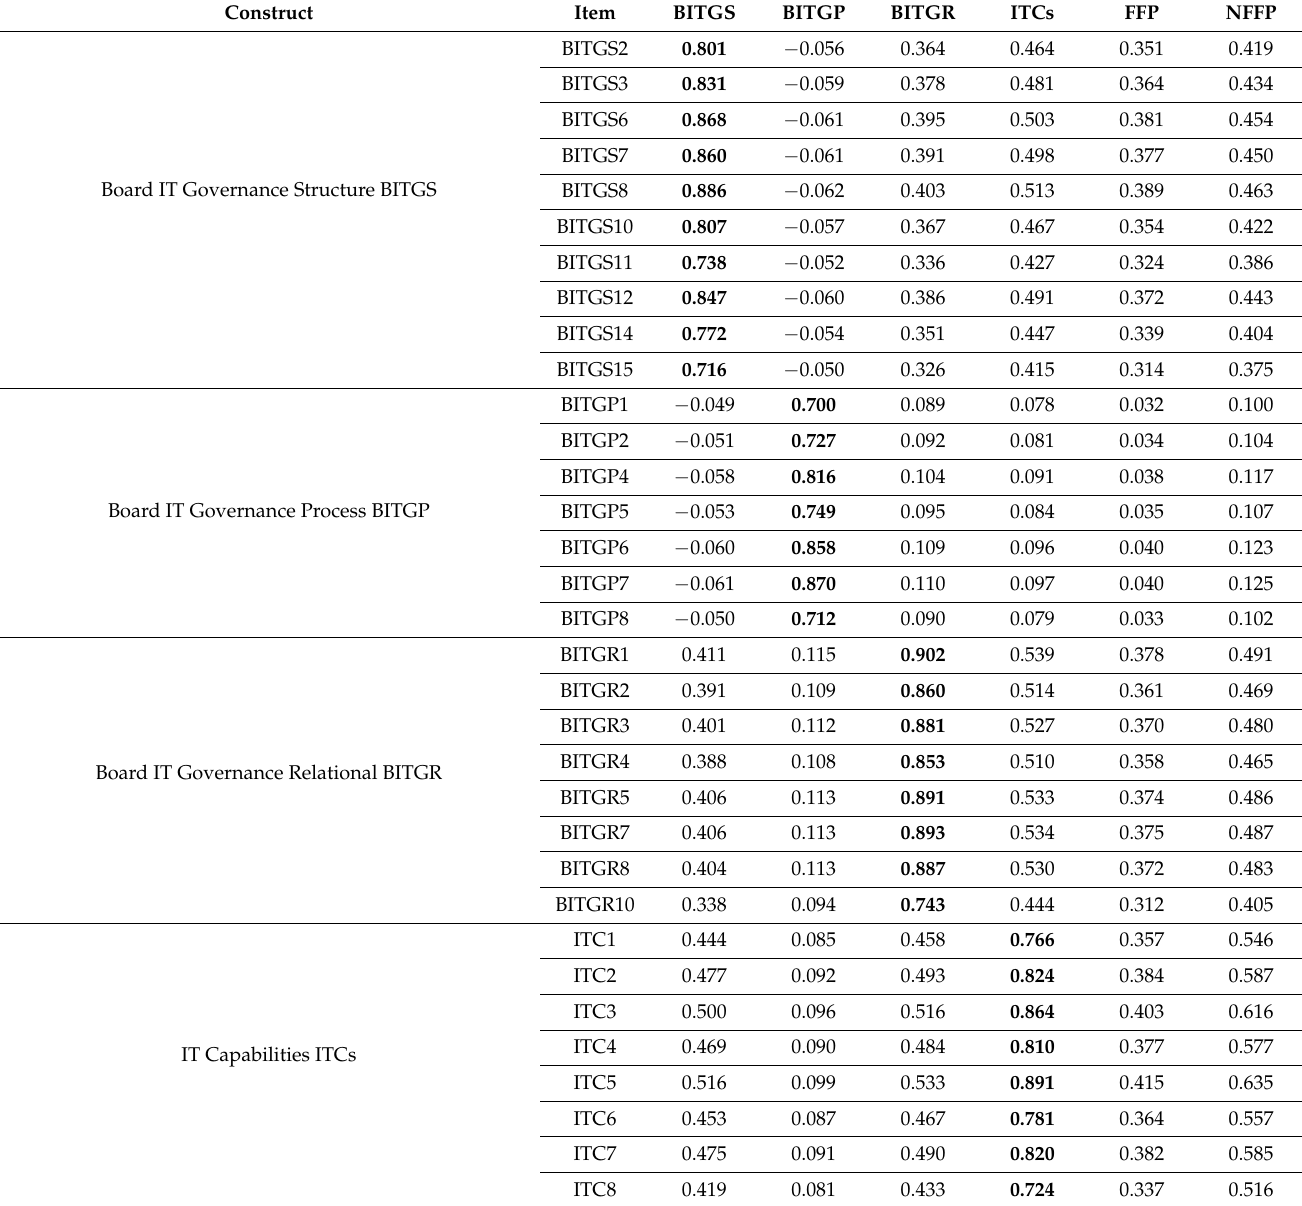
Table 2. Factor Loadings and Cross-Loadings for the Measurement